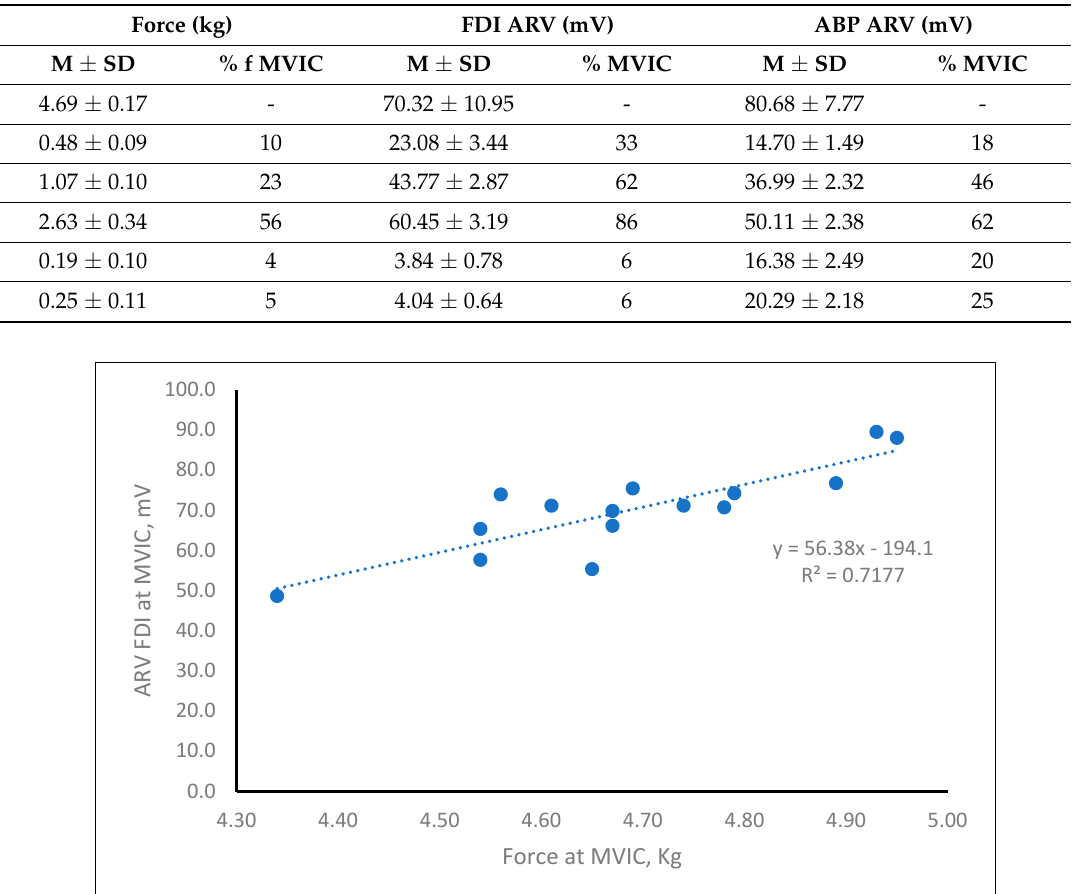
Table 2. Distribution of ARV values for the first dorsal interosseous (FDI) and the abductor brevis pollicis (ABP) measured during the different experimental steps in the worker sample (N = 15).